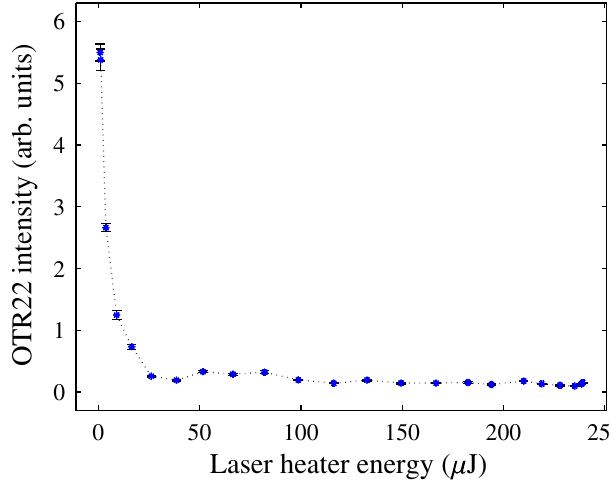
FIG. 14. (Color) COTR intensity on OTR22 (an OTR screen right after the second bunch compressor) vs LH energy.